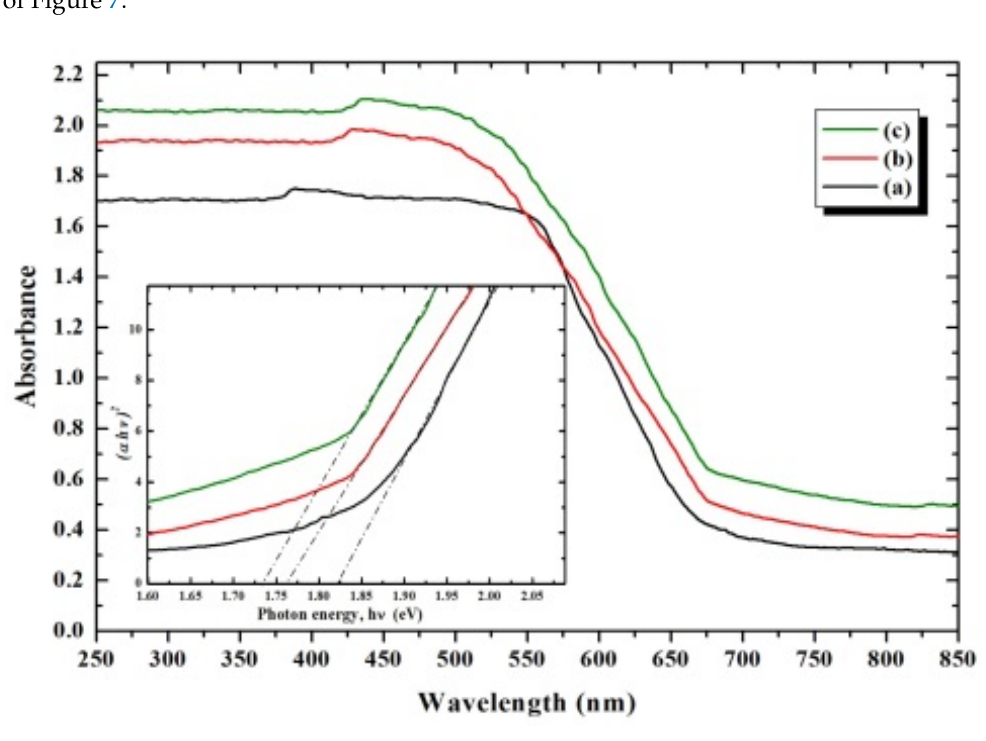
Figure 7. UV-Vis/DR spectra of BiFeVOx.y for ( a ) y = 0.03, ( b ) y = 0.07, and ( c ) y = 0.15. Inset shows ( α h υ ) 2 vs. h υ plots. Table 4. Optical band-gap energies and photocatalytic efficiencies of BiFeVOx.y photocatalyst